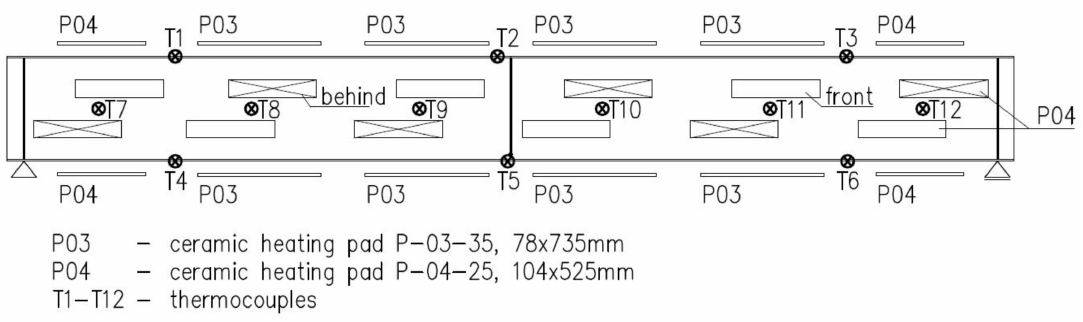
Figure 4. Distribution of thermocouples and ceramic heating